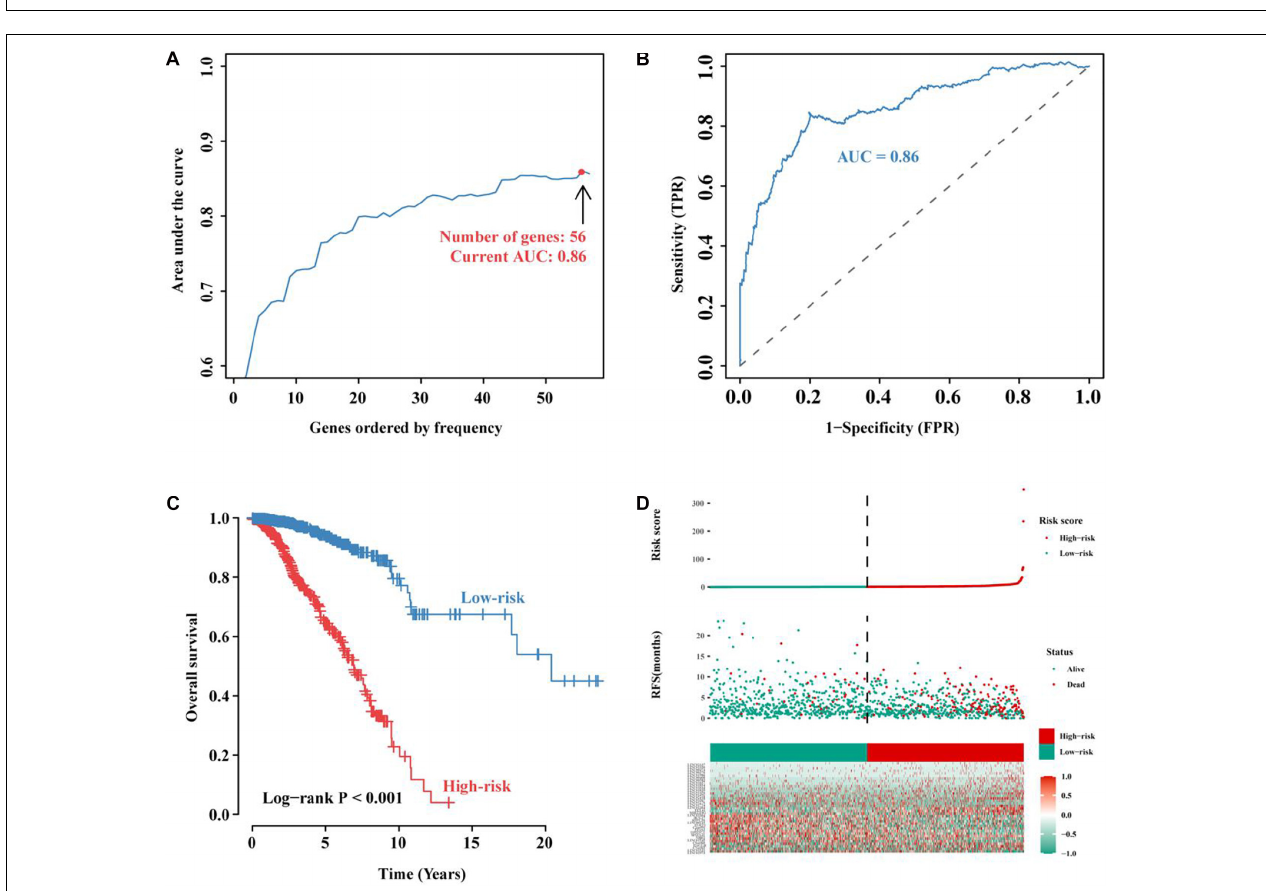
FIGURE 4 | Construction and evaluation of the immune-related 56-lncRNA signature. (A) The immune-related lncRNA signature constructed by the iterative Lasso Cox regression analysis. (B) ROC curve used to evaluate the predictive efficiency of the signature. (C) Kaplan-Meier curve for the OS of BC patients in the high- and low-risk groups. (D) Risk-score distribution. In the x -axis, red represents higher expression levels while green represents lower expression levels. Risk scores for BC patients in the high- (red, the y -axis) and low-risk groups (green, the y -axis) were listed in ascending order.